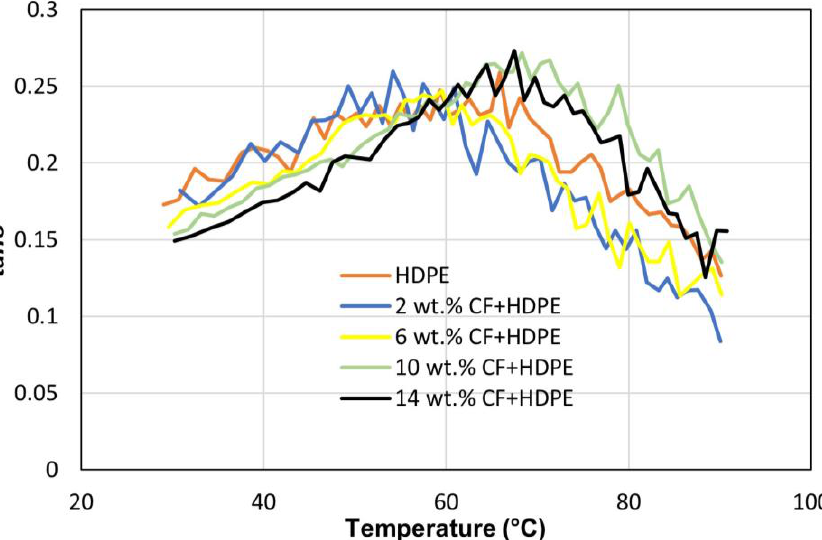
Figure 8. Effects of CFs on loss modulus ( E″ ).